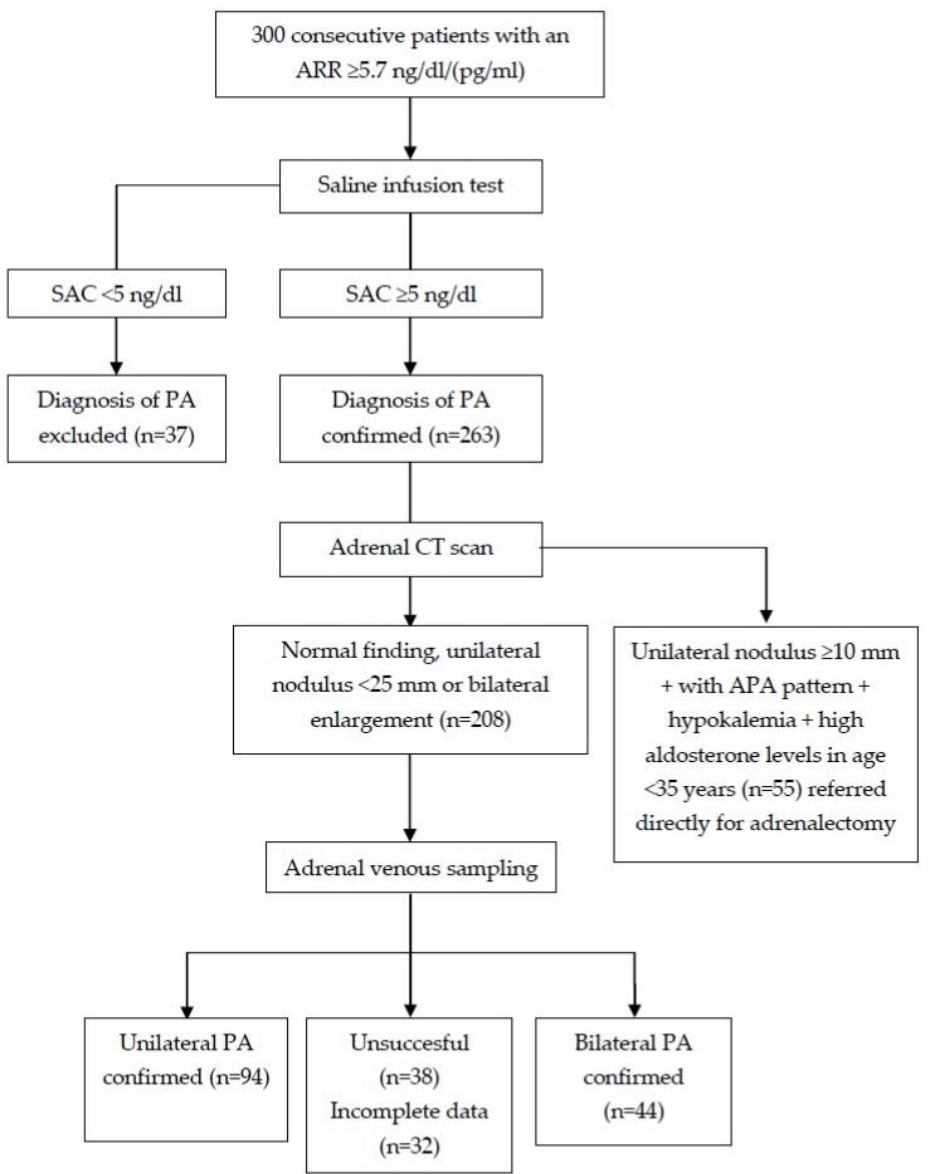
Figure 4. Flow chart of the recruitment into the validation cohort. APA—aldosterone producing adenoma; ARR—aldosterone to plasma renin activity ratio; PA—primary aldosteronism; PAC—plasma aldosterone concentration.